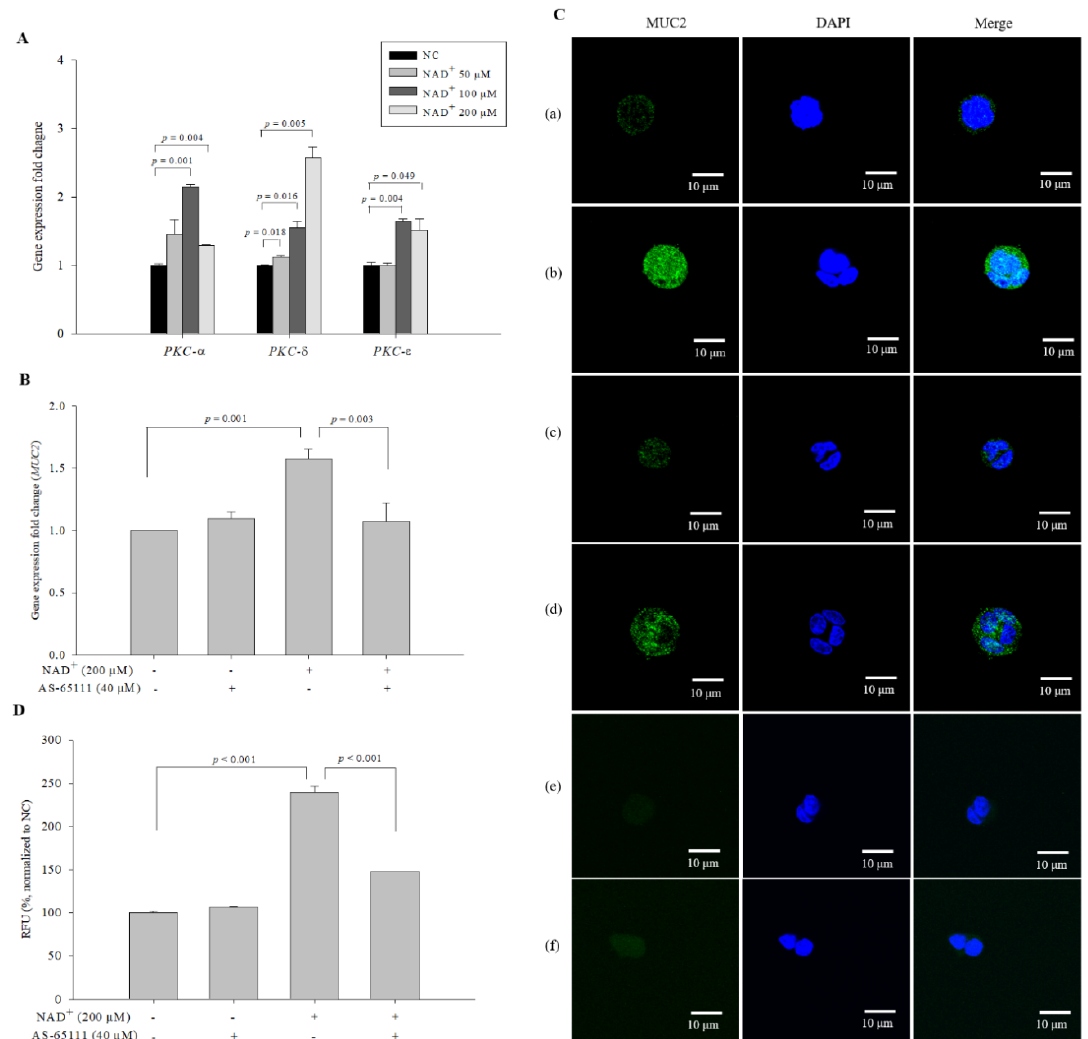
Figure 7. Effect of protein kinase C (PKC)-δ activation on MUC2 expression. ( A ) The expression levels of PKC-α , PKC-δ , and PKC-ε were investigated with qPCR. AS-65111 was used to inhibit PKC-δ. MUC2 expression was measured at the gene level ( B ) and at the protein level using ICC (magnification 600×) ( C ). To clarify that the secondary antibodies were not affected by the generation of the fluorescence signal, the preparations of the negative control and 200 µM NAD + -treated cells were created by omitting the primary antibody. ( a ) Negative control, ( b ) 200 µM NAD + , ( c ) 40 μM AS-65111, ( d ) 200 µM NAD + , and 40 μM AS-65111, ( e ) negative control without the primary antibody, ( f ) 200 µ M NAD + without the primary antibody. The fluorescence intensity was quantified ( D ). The data are expressed as the mean ± SD of three independent experiments performed in triplicate. The symbols + and − indicate chemical treatment and non-treatment,